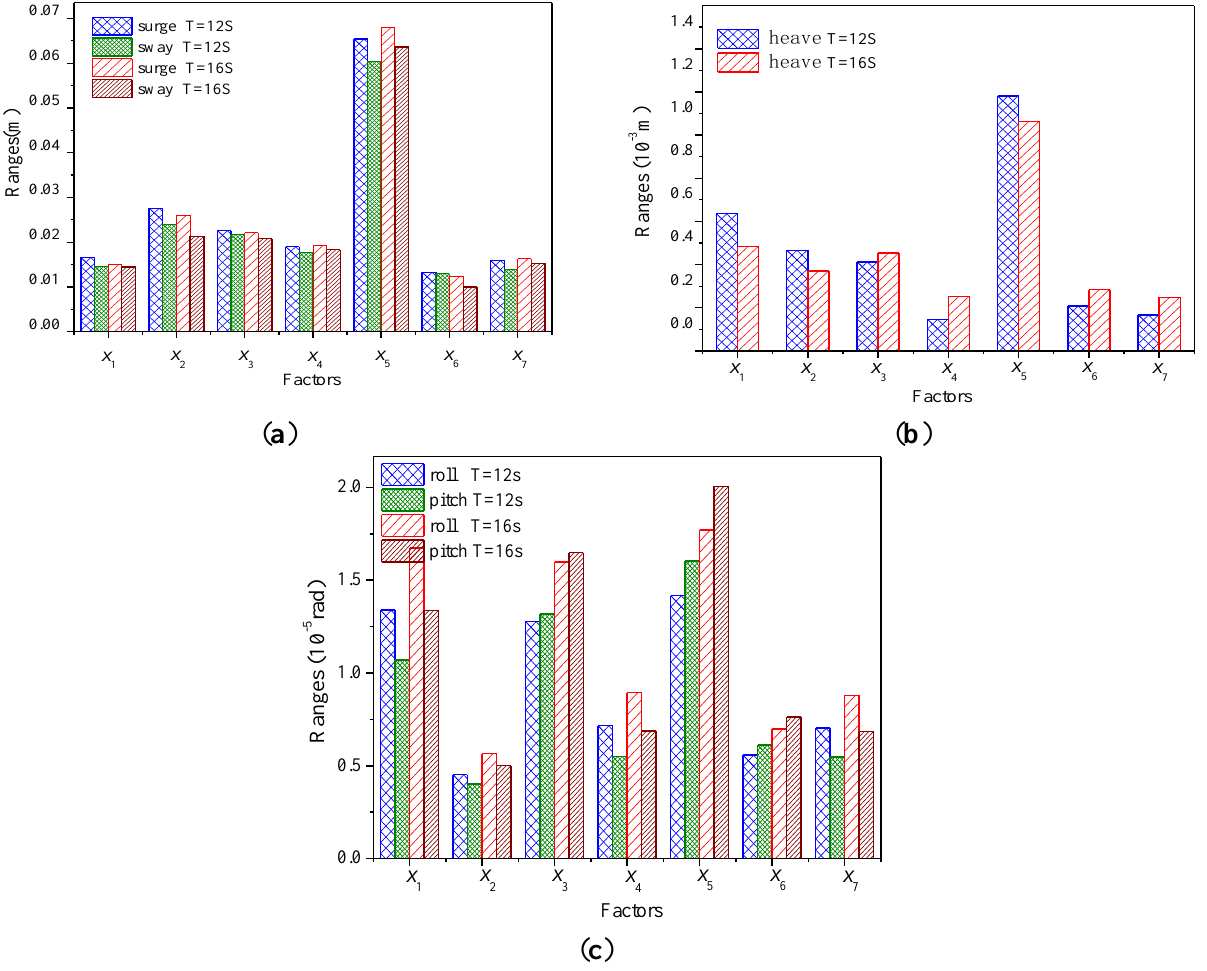
Figure 6. Range analysis of surge, sway, heave, pitch, roll for ( a ) surge, sway; ( b ) heave; ( c ) roll,